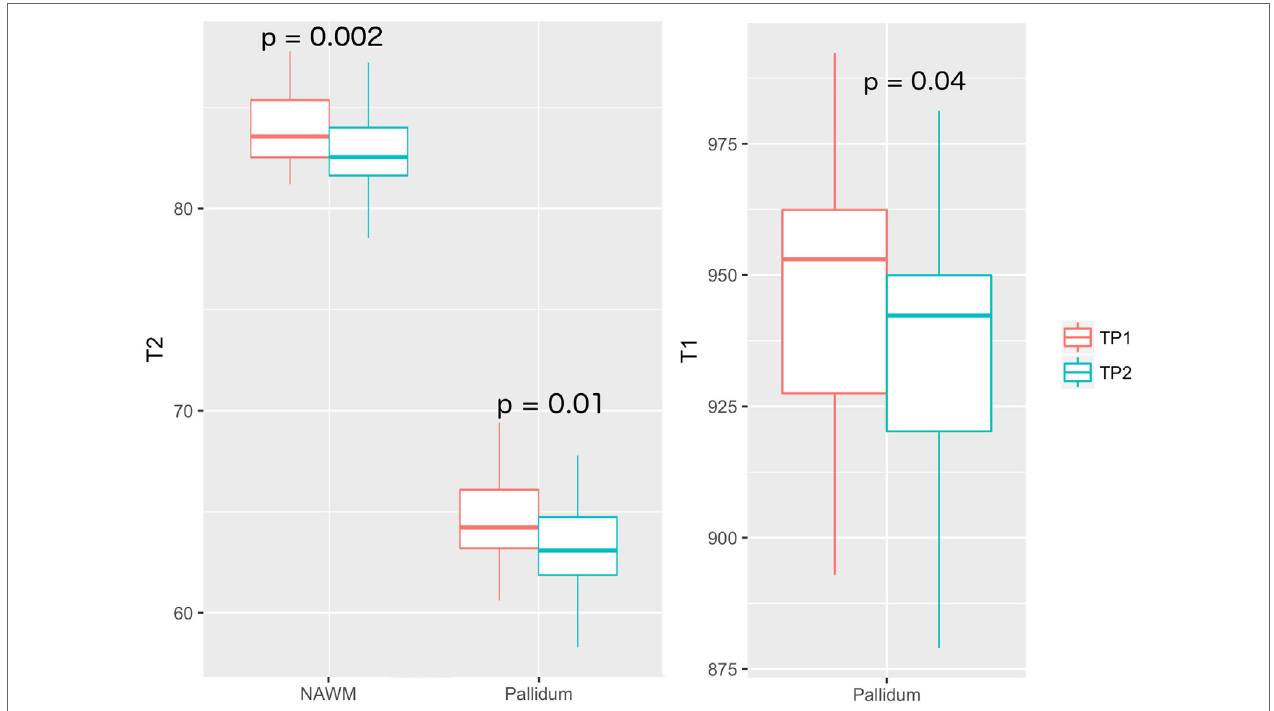
FigUre 3 | Mean T2 relaxation times in NAWM and pallidum of MS patients, at both time-points (left). Mean T1 relaxation times in pallidum of MS patients